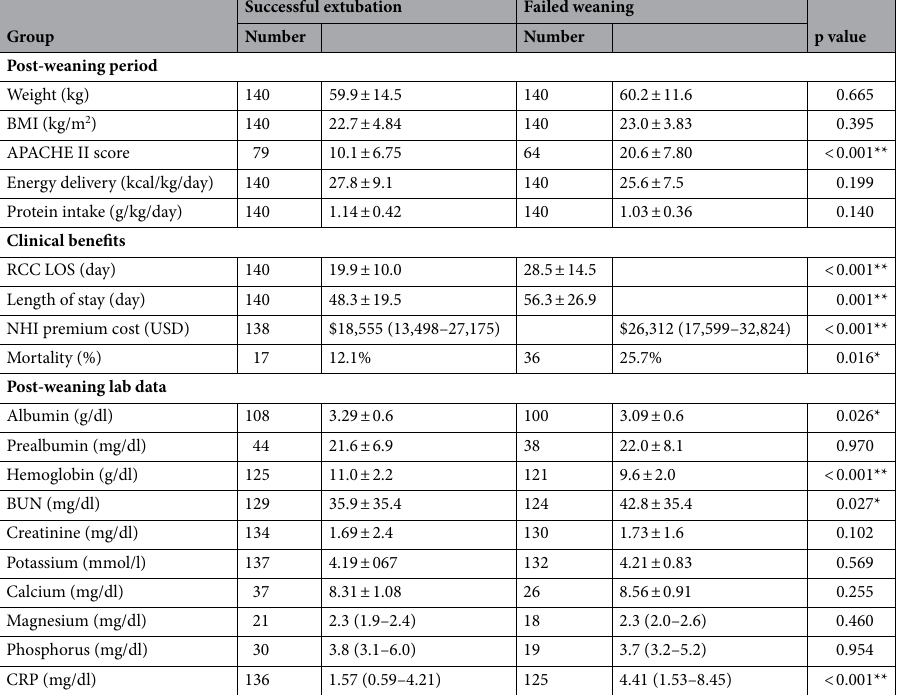
Table 3. Comparisons of total outcomes between groups. Continuous data are expressed as mean ± SD and p values are from independent t test. Categorical data are expressed as n (%) and the p values are from the Pearson chi-square test. NHI premium cost and laboratory values are presented as median (25th to 75th percentiles), with p values from the Mann–Whitney U test. Mortality rates were compared using log-rank tests for survival analysis. *p value < 0.05 and **p value < 0.01 are considered statistically significant and extremely significant, respectively. BMI Body Mass Index, APACHE II score Acute physiology assessment and chronic health evaluation II score, RCC LOS Respiratory care center length of stay, NHI National Health Insurance, BUN blood urea nitrogen, CRP high sensitivity C reactive